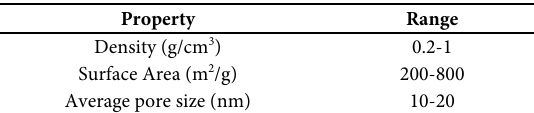
Table 1. The properties of RF aerogel